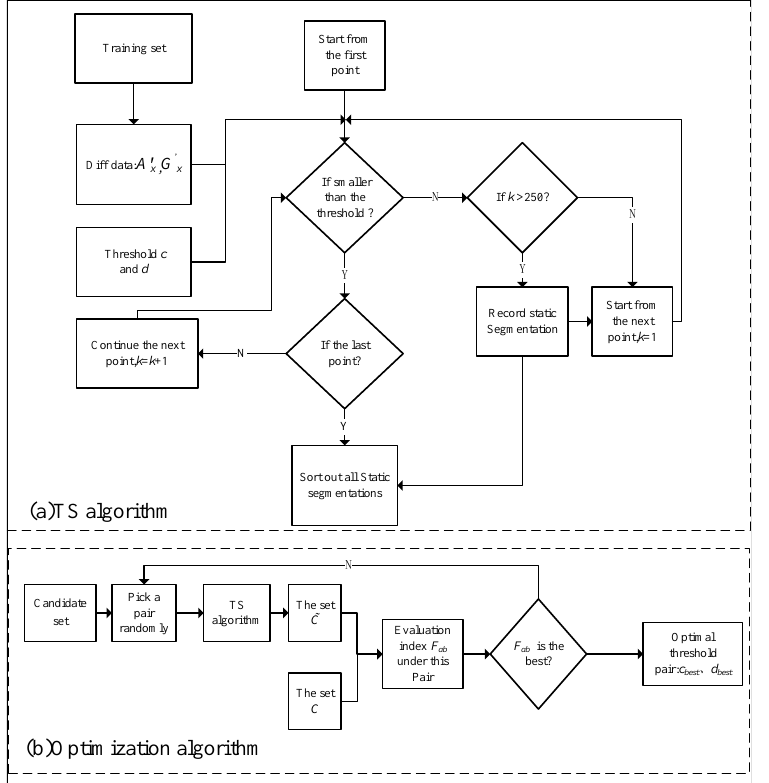
Figure 4. Flow chart of the proposed TS algorithm. ( a ) TS algorithm, and ( b ) Optimization algorithm. For a complex time series, the starting point of the focused activity is often manually < r ≤ t and 1 ≤ i ≤ K } , where 1 ≤ u identified [7]. C = { S u , S u , . . . , S u , . . . , S u i i K r K 2 r 2 i r i 1 r 1